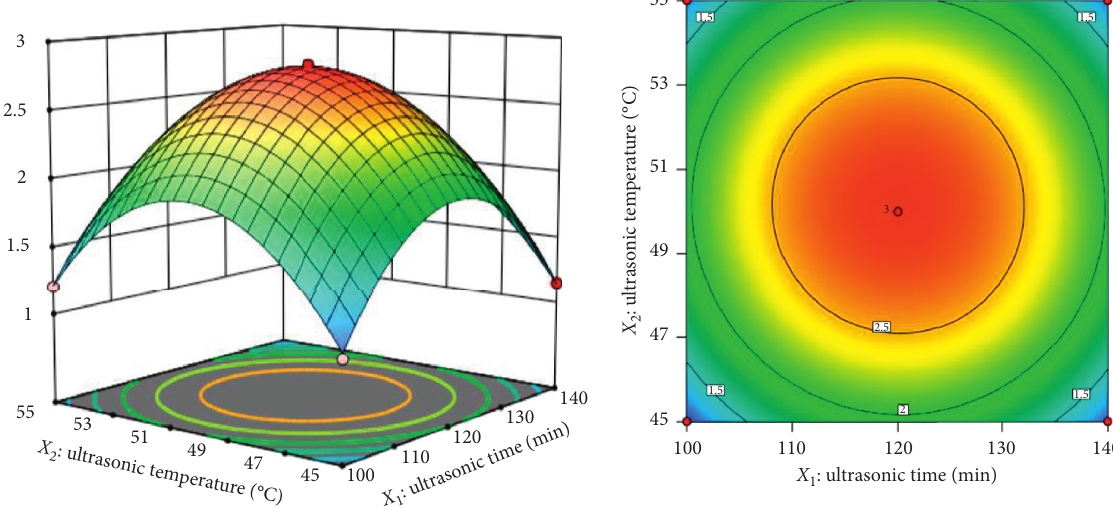
Figure 8: Simultaneous effect of ultrasonic time and ultrasonic temperature.